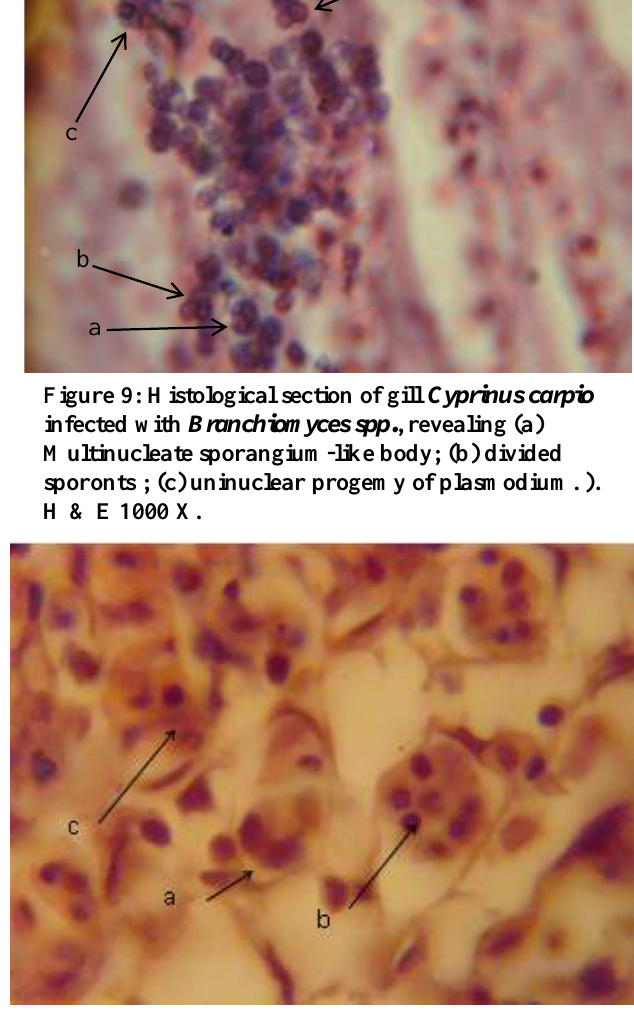
Figure 11: Histological section of gill Cyprinus carpio infected with Branchiomyces spp., revealing hypha containing (a) plasmidium (b) uninuclear progemy of plasmodium